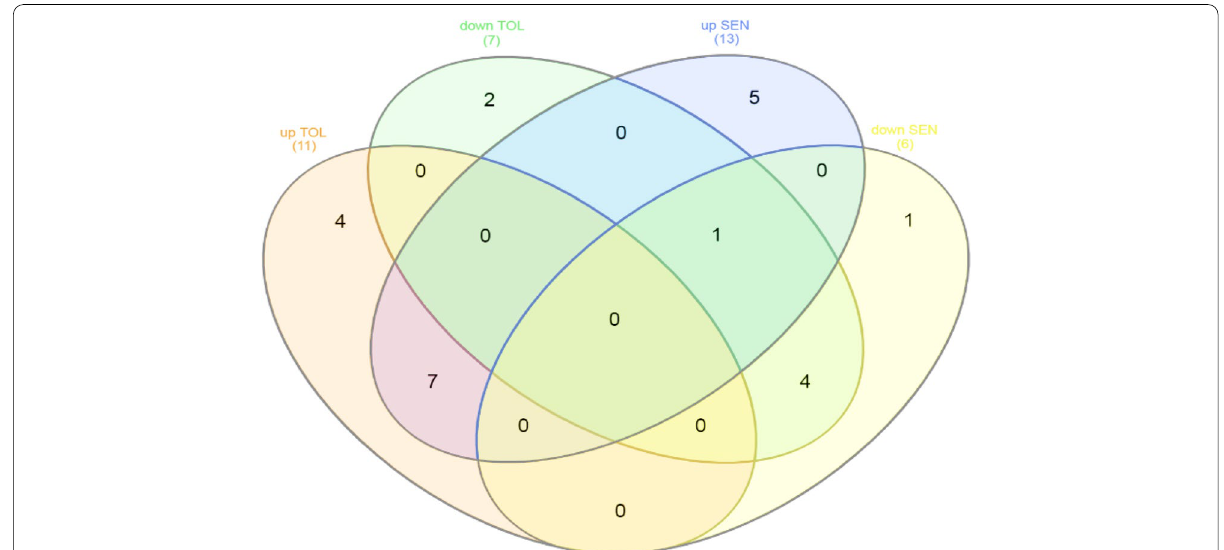
Fig. 3 Significant expression Transcription factor genes in result of